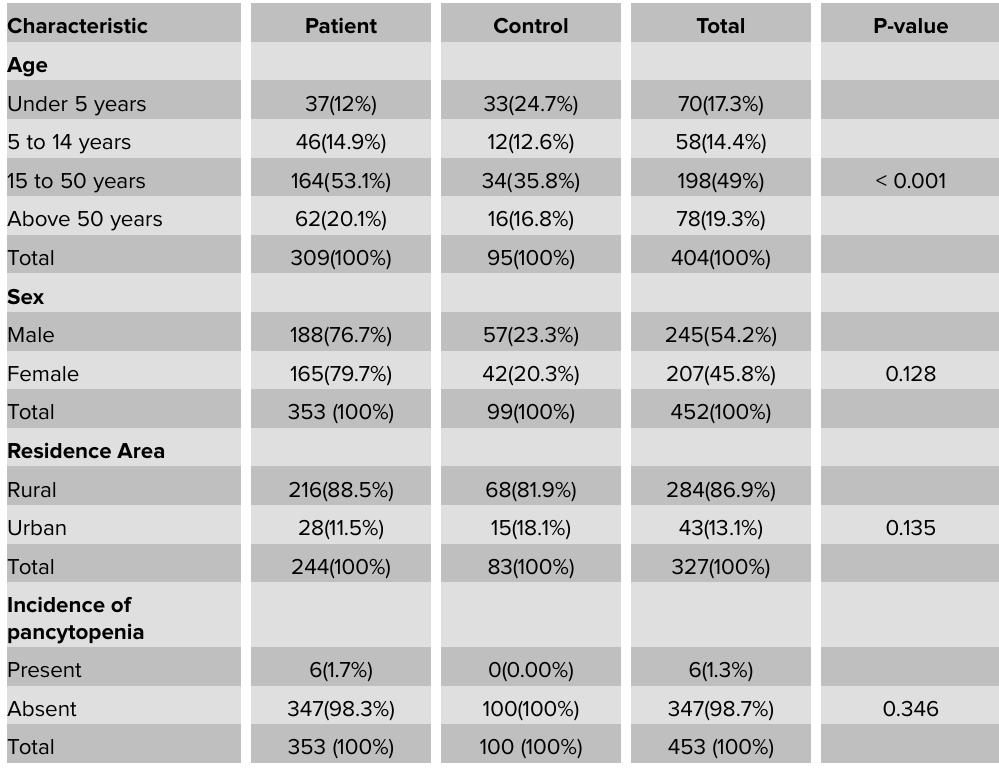
Table 1: Characteristics and description of the study